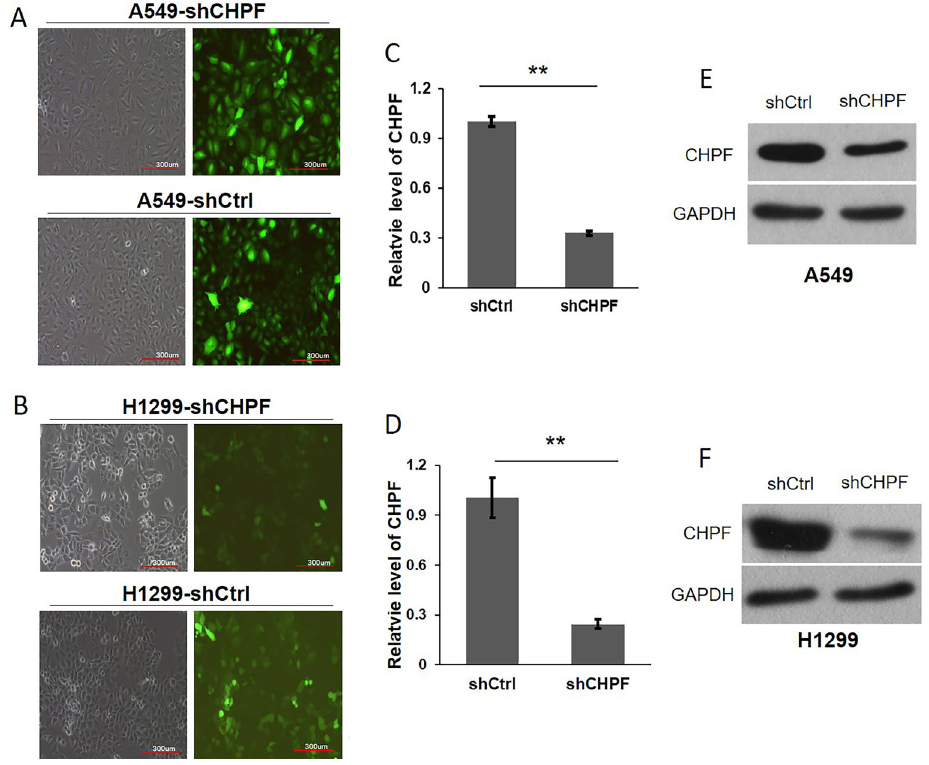
Figure 2. shRNA lentivirus transduction and con fi rmation. A and B , Lentiviral vector expressing sh CHPF or shCtrl was transduced into A549 and H1299 cells. Infection ef fi ciency was con fi rmed by fl uorescence microscopy at 72 h. C to F , qRT-PCR and western blotting were used to con fi rm the knockdown ef fi ciency of CHPF . **P o 0.01 (Student ’ s t -test). CHPF : chondroitin polymerizing